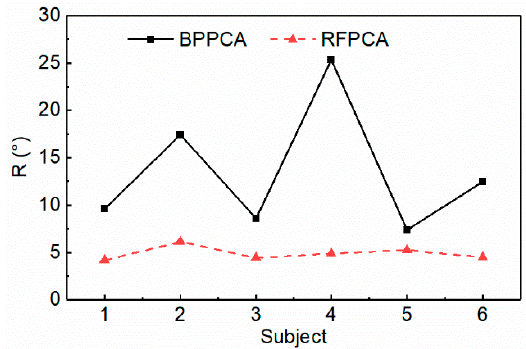
ff erent models for di ff erent subjects when n = Figure 10. The evaluation metric of different models for different subjects when n = 2. Figure 10. The evaluation metric of di